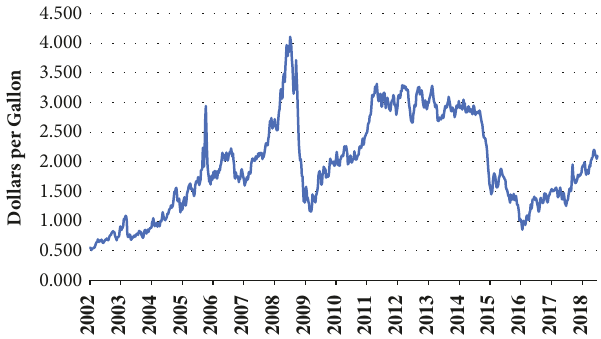
Figure 3: Kerosene-type jet fuel prices in US Gulf Coast [10].